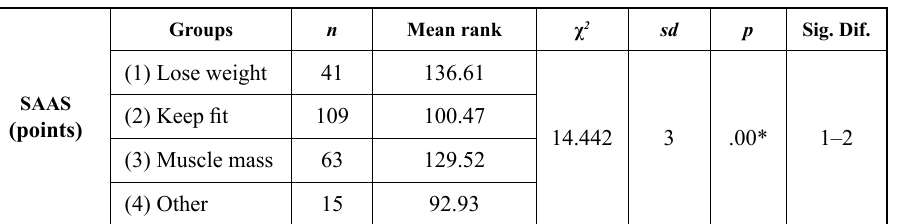
Table 4. Distribution of the SAAS points by the reason of attending the